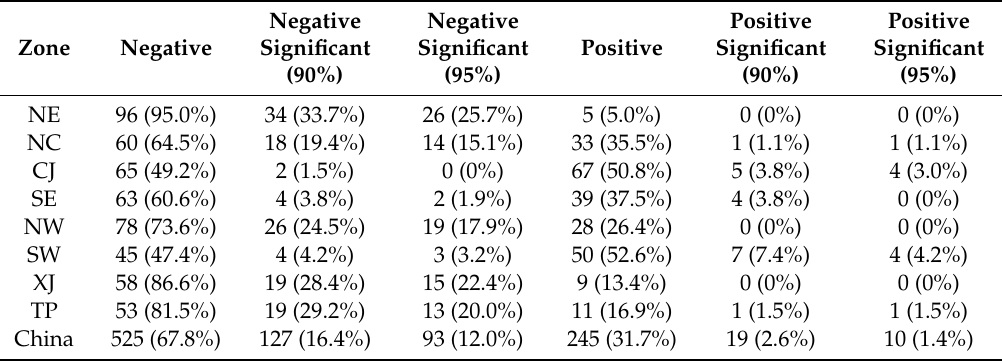
Figure 5. The spatial distribution of rainfall stations displaying negative or positive PCI trends across China. ( a ) The overall station trends (The blue downward triangles denote decreasing trends; the red upward triangles denote increasing trends) and ( b ) the stations exhibiting statistically significant trends (The blue circles denote decreasing trends, the red circles denote increasing trends, the bigger circles show trends exhibiting a 95% significance level detected by the MK test, and the smaller circles show trends exhibiting a 90% significance level detected by the MK test). Table 1. PCI trends obtained by the Mann–Kendall for all subregions in